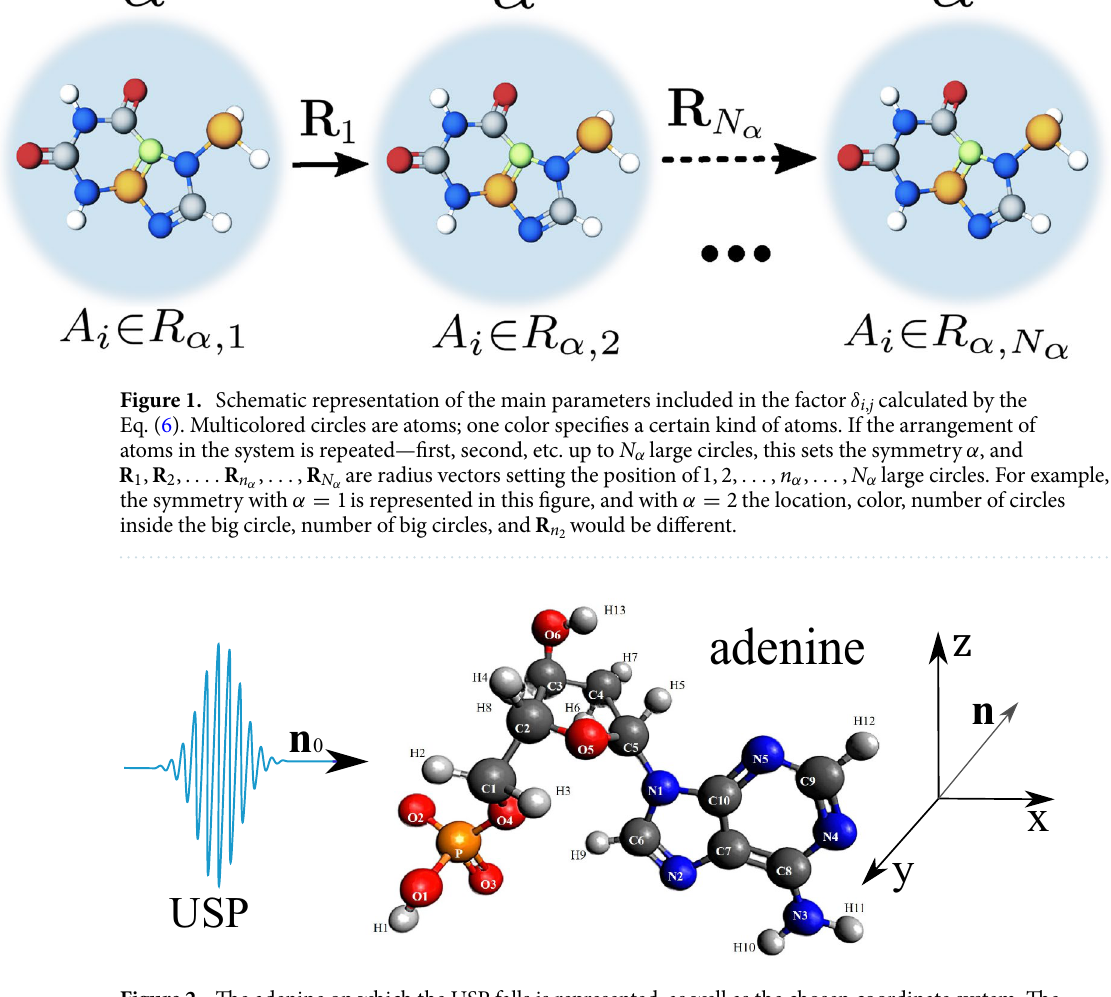
Figure 2. The adenine on which the USP falls is represented, as well as the chosen coordinate system. The calculation was performed in the spatial orientation of the adenine in relation to the USP in the chosen coordinate system shown in this